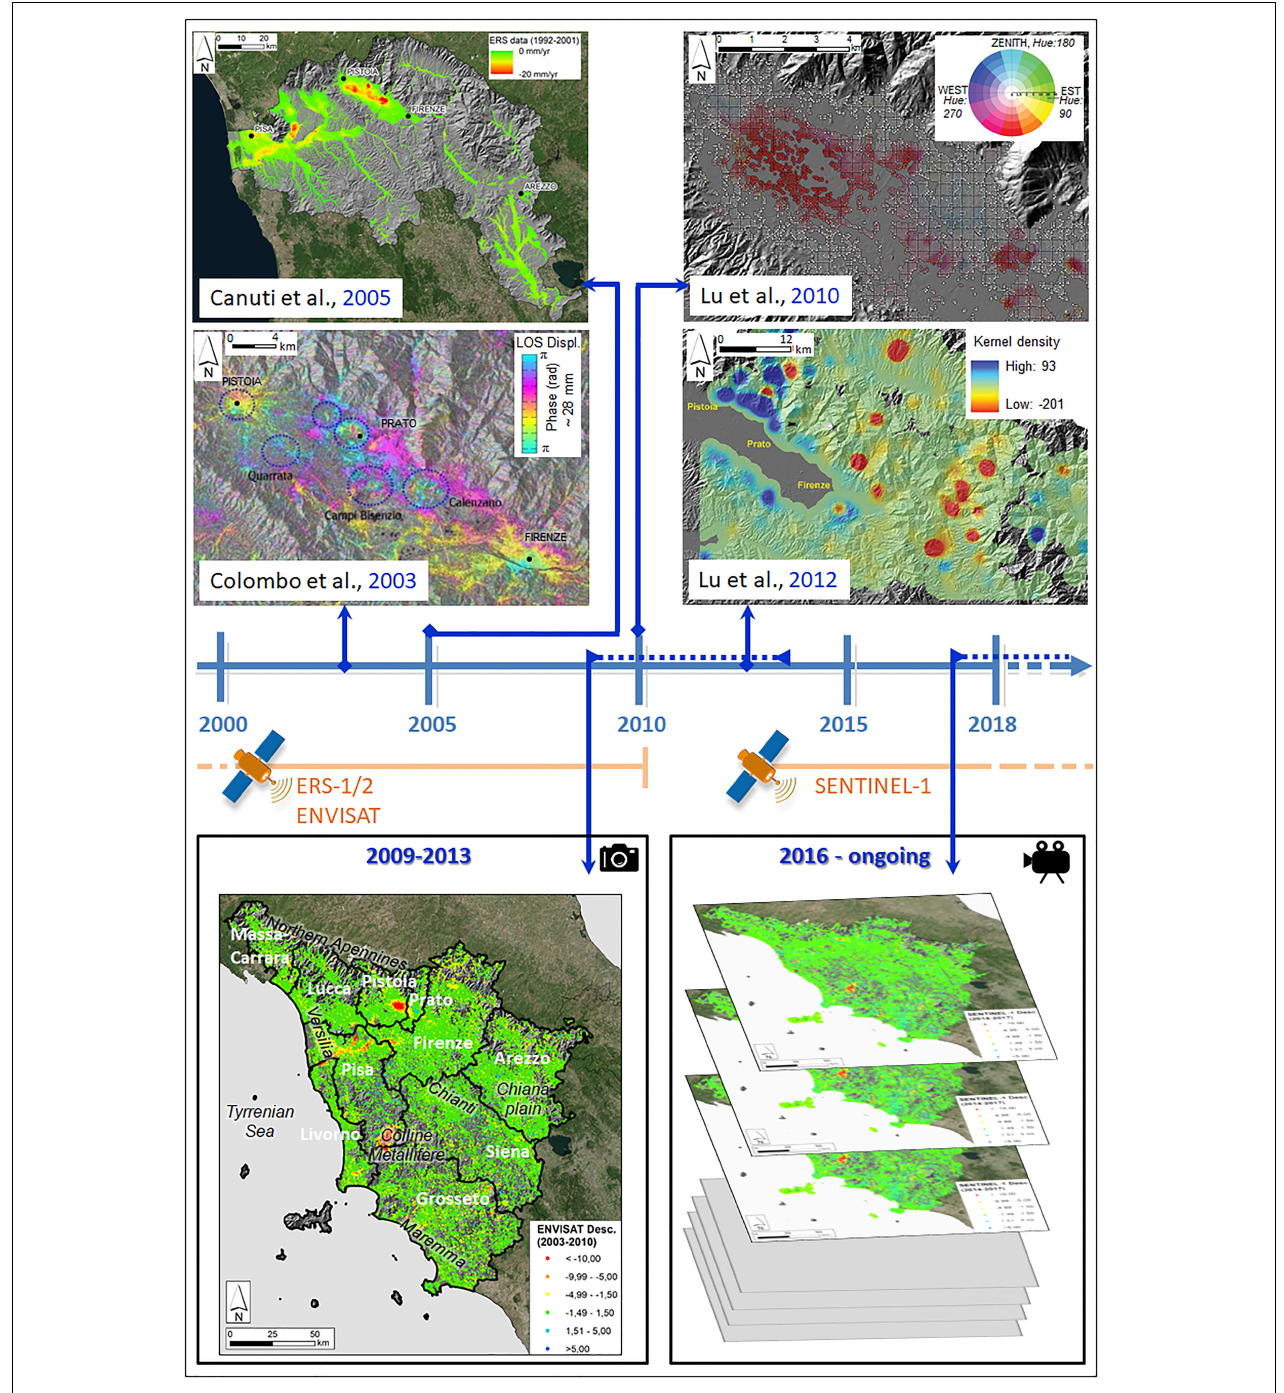
FIGURE 1 | Overview of past and recent InSAR applications in the Tuscany Region, Italy (modified after Colombo et al., 2003; Canuti et al., 2005; Lu et al., 2010, 2012; Rosi et al., 2018. We have obtained the copyright permissions to use already published figures).